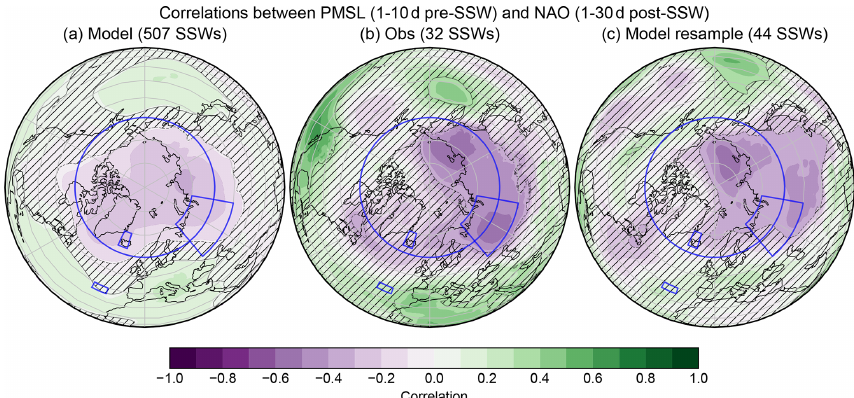
Figure 4. Correlation of surface precursors with the NAO response to SSWs. The left and centre panels show the correlations between the 10d pre-SSW PMSL fields and the 30d post-SSW NAO anomalies for (a) the model and (b) observations. The right-hand panel (c) shows the correlation map for a particular case from the hindcast resamples, chosen as the sample whose correlation map has the highest spatial correlation with the observed correlation map for points north of 40 ◦ N (0.83). In each panel, the 95% confidence intervals are marked with a contour, and areas where the correlation is indistinguishable from zero are hatched. Regions used in our analysis (the NAO boxes, a Ural region, and the polar cap) are outlined in